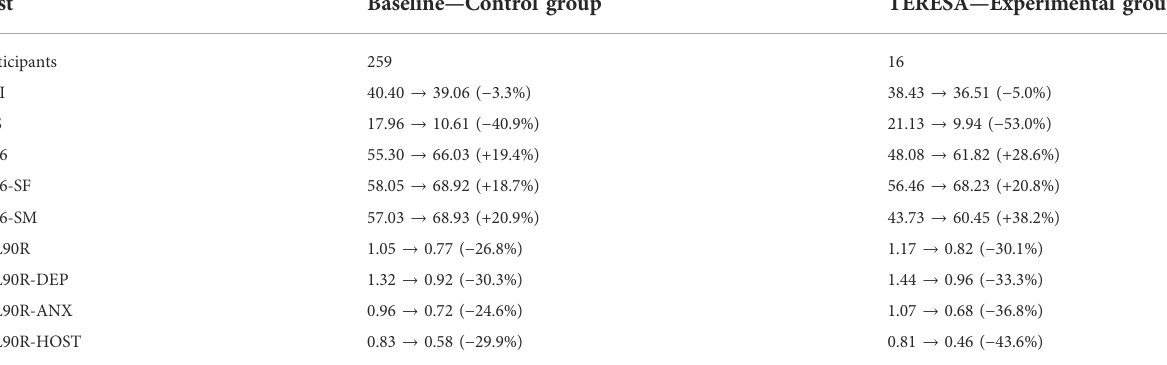
Test Baseline — Control group TERESA — Experimental